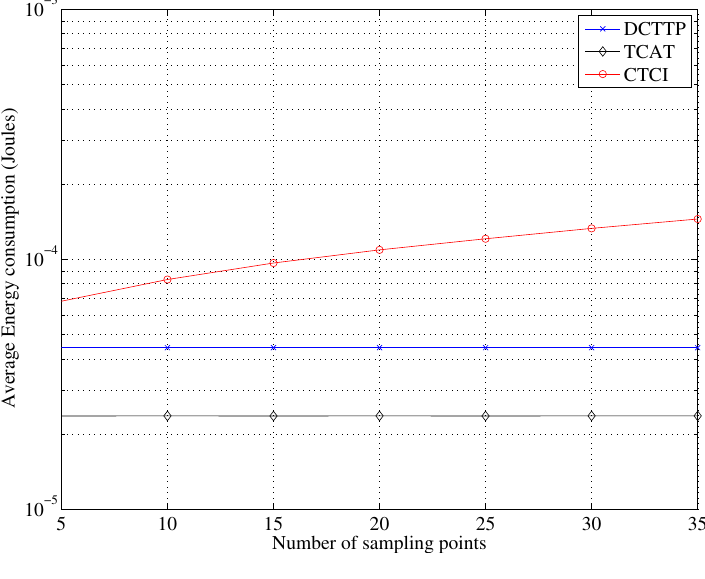
Figure 22. Impact of the sampling points on the average energy